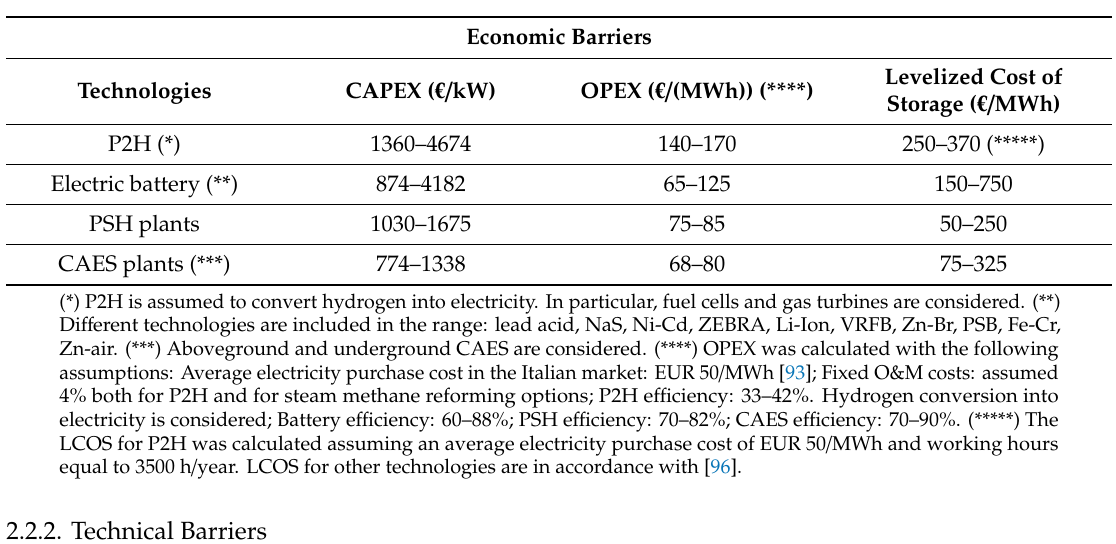
Table 2. Economic barriers. CAPEX and OPEX are referred to by the unit of power (kW) stored. Data from